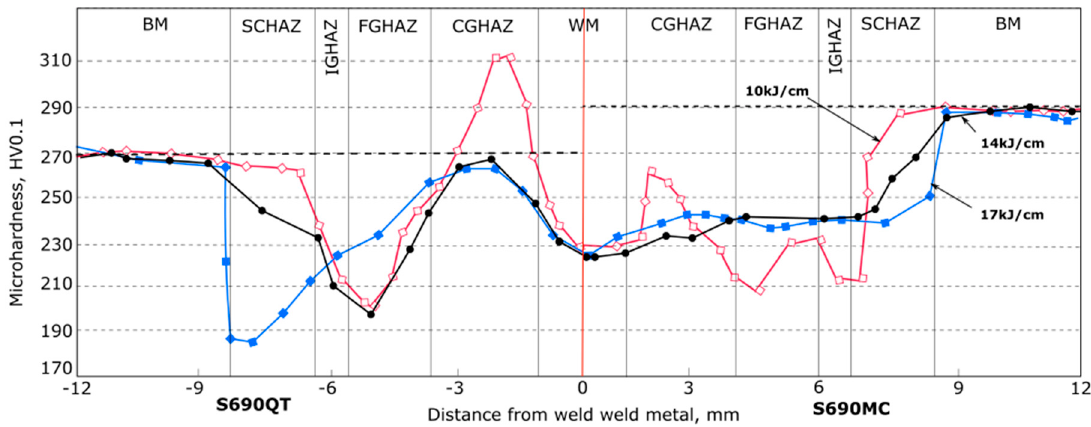
Figure 13. Effect of heat input on the microhardness profile of the welded joints: ( left ) QT steel; ( right ) TMCP steel. The dotted line shows the base metal hardness.